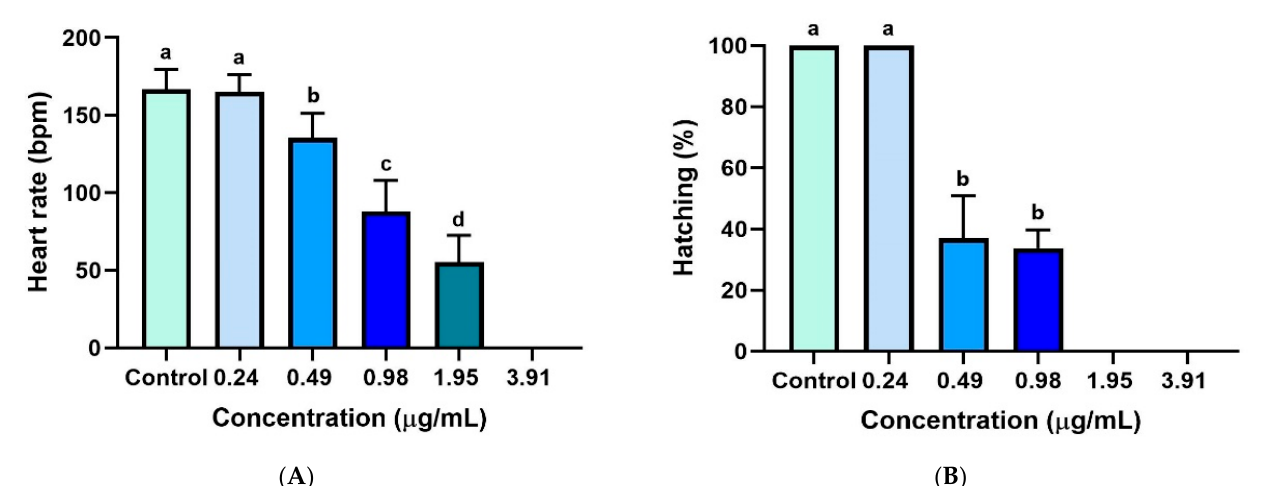
Figure 5. Assessment of hatchability and heart rate of zebrafish embryos. ( A ) Percentage of embryos hatching of zebrafish treated with ZO essential oil. ( B ) Correlation between the dose of ZO essential oil and zebrafish larvae heart rate (bpm) at 72 hpf. Data are presented as mean ± SD of three independent experiments ( n = 60 embryos/group). Data were analyzed using one-way ANOVA and Tukey’s multiple comparison test. Different lowercase letters indicate significant differences between groups ( p < 0.05).